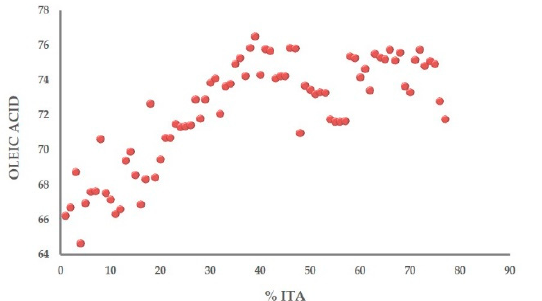
Figure 6. Integral of the area underlying the peaks corresponding to oleic acid in the NMR spectrum ( a ) 1.03 and ( b ) 2.02 ppm correlated with the Italian component in the blends.